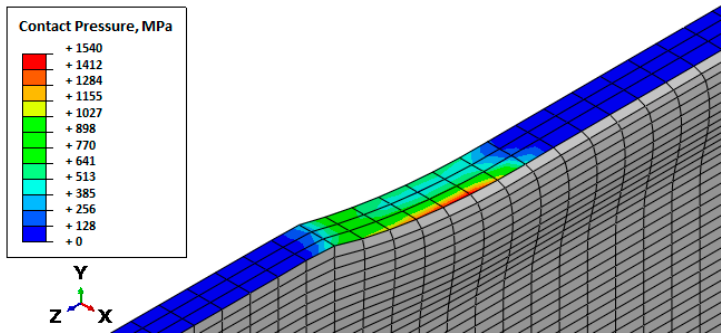
Figure 7. Contact pressure during rolling in 3D short implicit transient model.